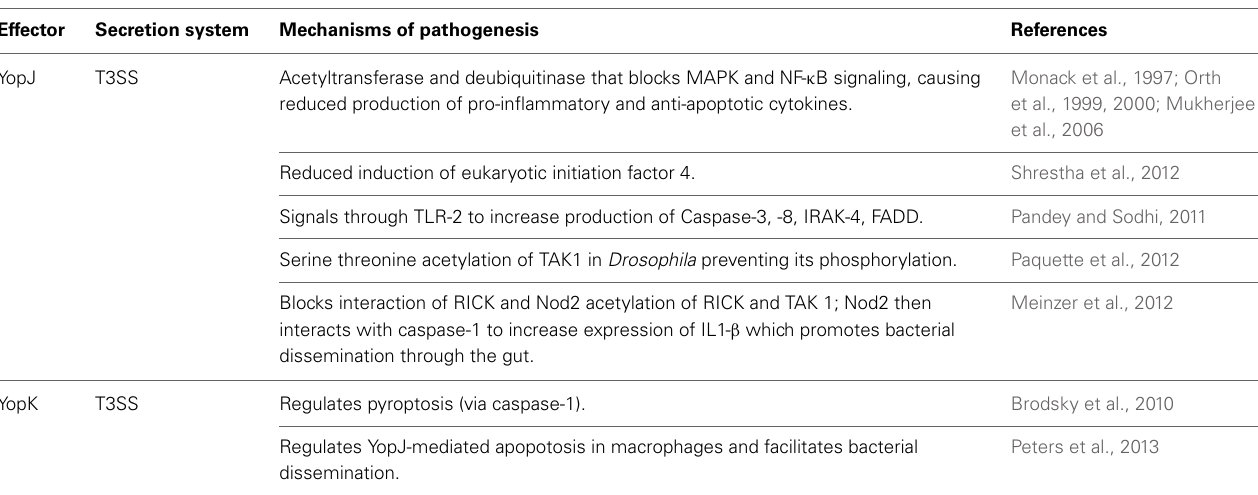
Table 1 | The mechanisms of action of yersiniae effectors YopJ and